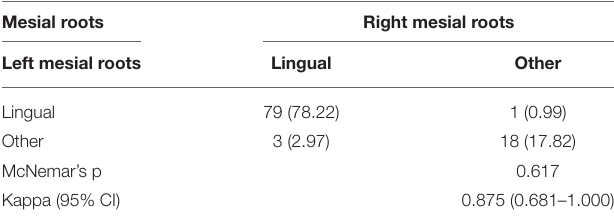
TABLE 2 | Evaluation of the same buccal-lingual relationship between the left and right mesial tooth roots for each dog. Mesial roots